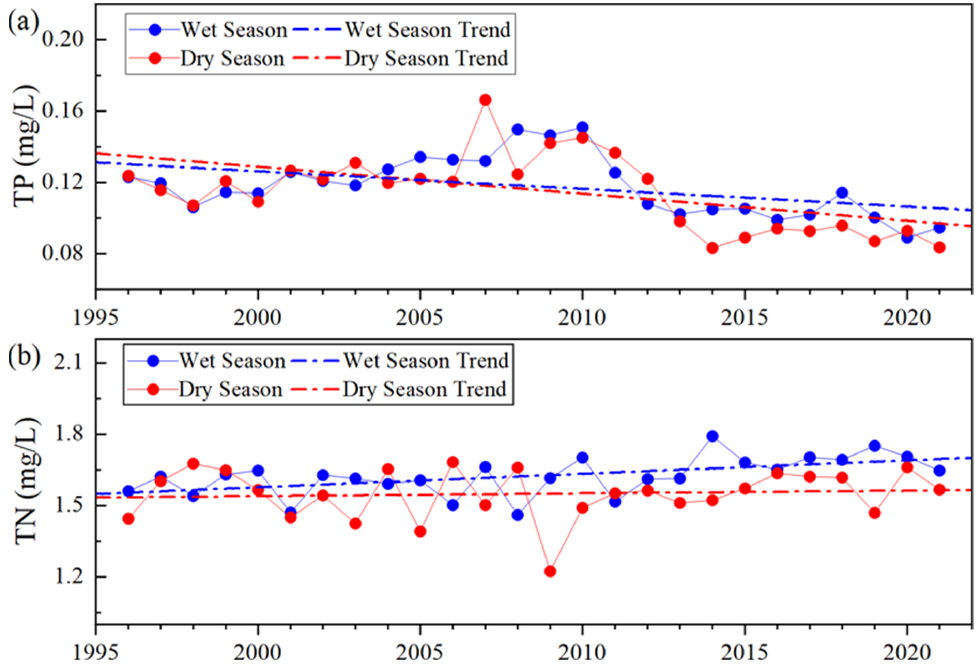
Figure 9. Comparison of TP ( a ) and TN ( b ) variations in Dongting Lake in the wet season and dry season.